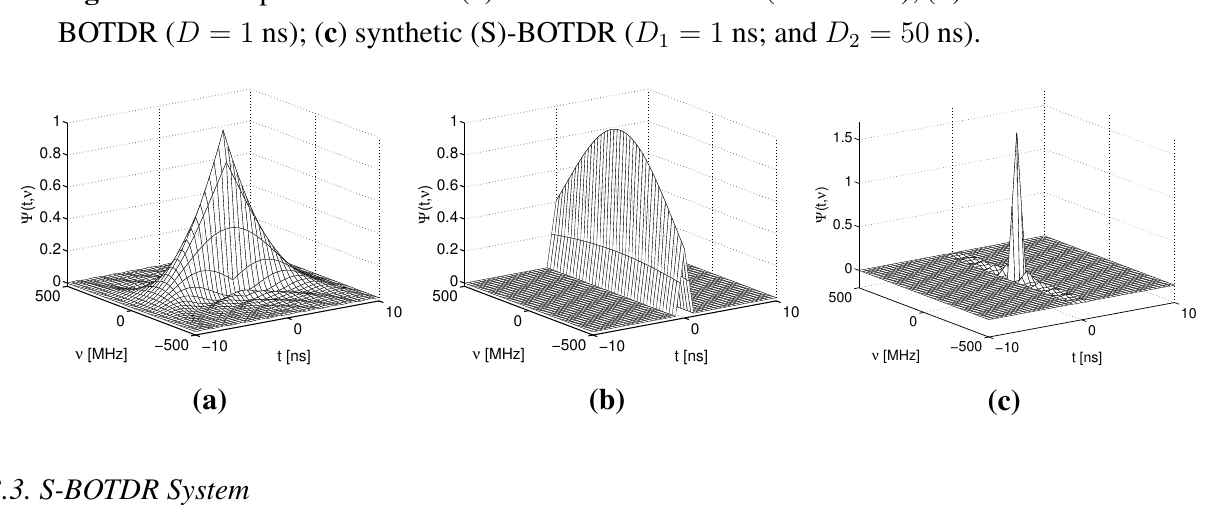
Figure 4. Point spread functions: ( a ) conventional BOTDR ( D = 10 ns); ( b ) conventional BOTDR ( D = 1 ns); ( c ) synthetic (S)-BOTDR ( D